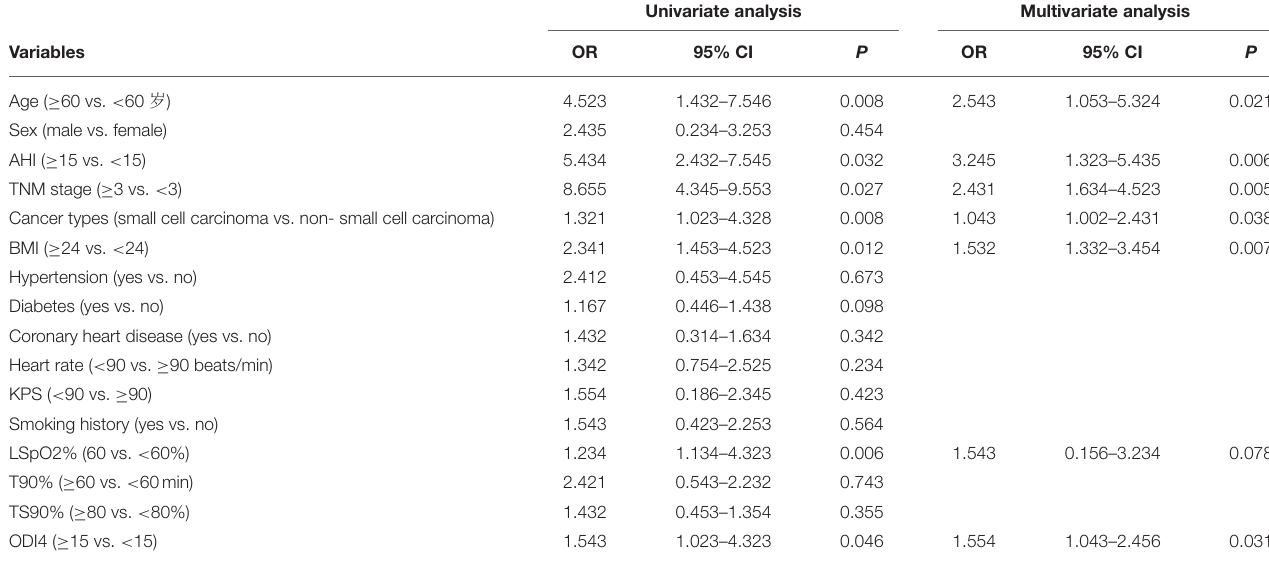
TABLE 3 | Univariate and multivariate Cox hazards analysis between clinical features and OS ( n = 90). Univariate analysis Multivariate